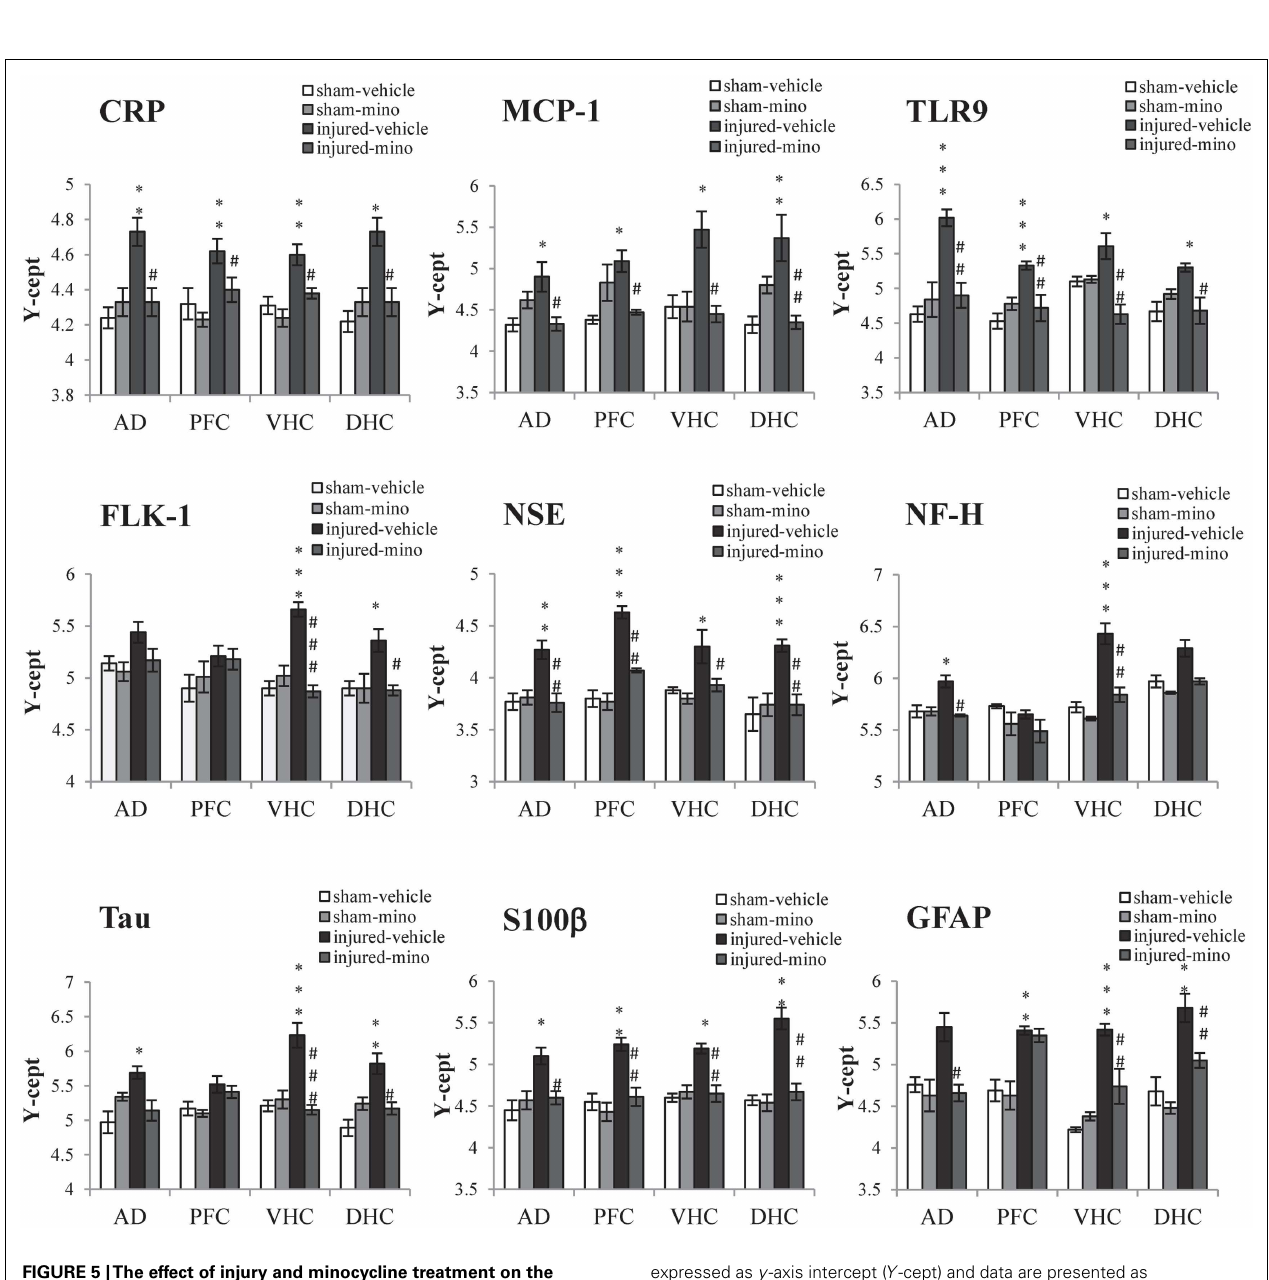
FIGURE 5 |The effect of injury and minocycline treatment on the levels of protein markers in various brain regions in the different experimental groups. Tissue levels of 9 protein markers were measured in the AD, PFC,VHC, and DHC of rats by RPPM. Protein values are